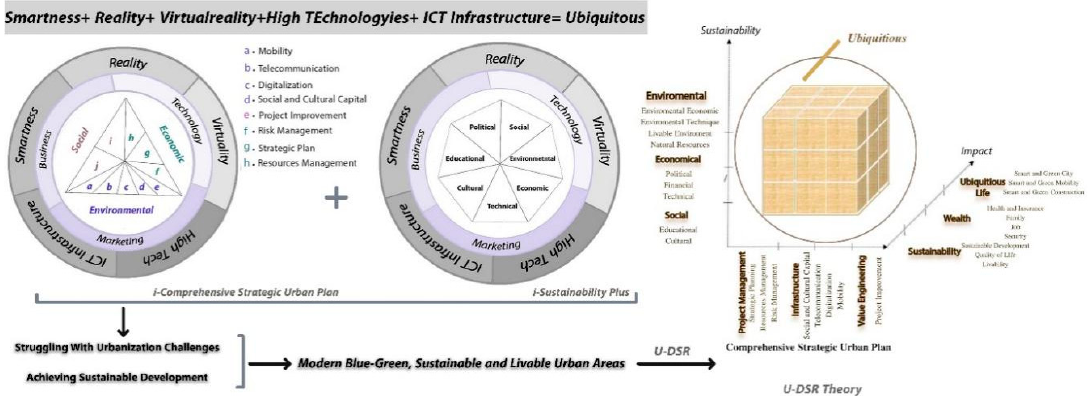
Figure 10. i -LUA Theory on Mobility.